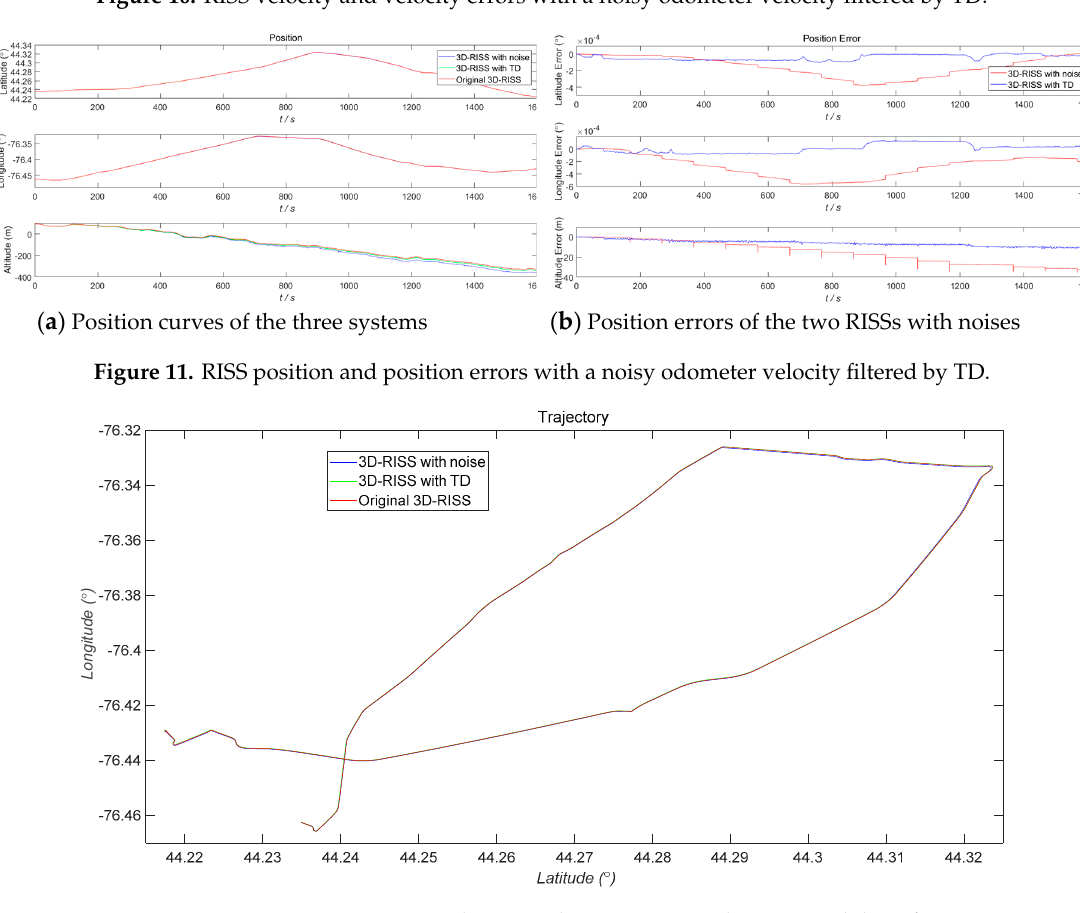
Figure 12. 2D trajectory comparison between the two RISSs with noises and the reference.